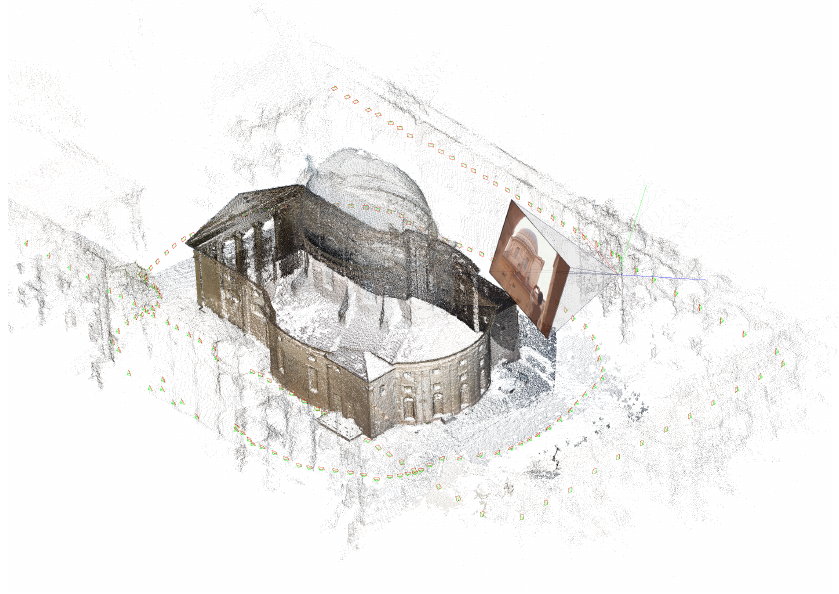
Figure 7. Vasarely dataset : data fusion with high scaling deviation ( Initial iteration in green and Incremental set in blue.